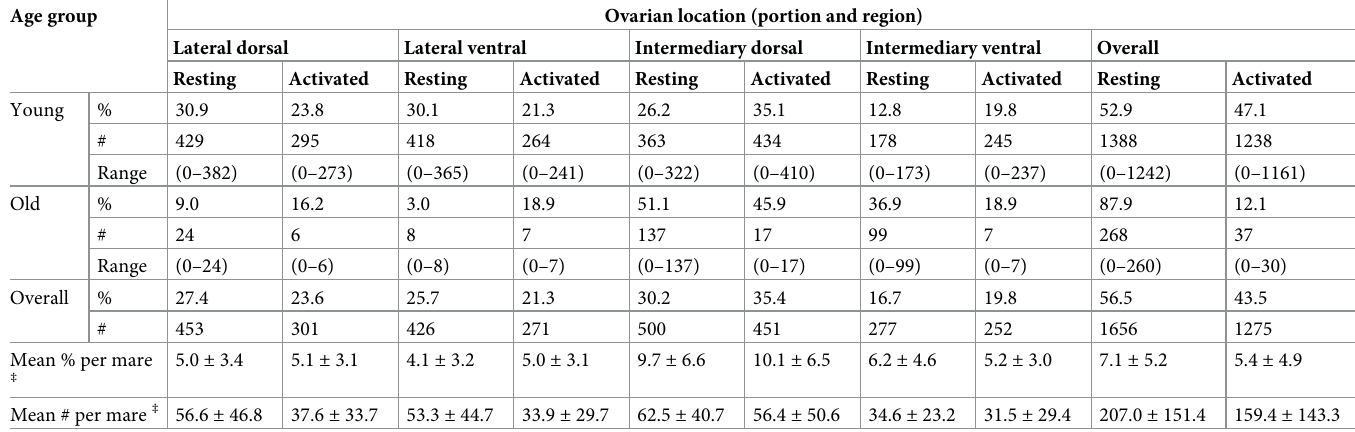
Mean # per mare ‡ 56.6 ± 46.8 ‡ No differences ( P > 0.05) were observed between ovarian locations within the same developmental stages, between developmental stages within the same ovarian locations, or when ovarian locations were pooled (overall) between developmental stages. A total of 206 histological sections were evaluated (25.8 ± 1.1 sections per mare). Descriptive percentages were calculated within a row for the same age group and developmental stage. All mean data were analyzed using one-way ANOVA after arc sin square root transformation for percentage data or log 10 transformation for non-percentage